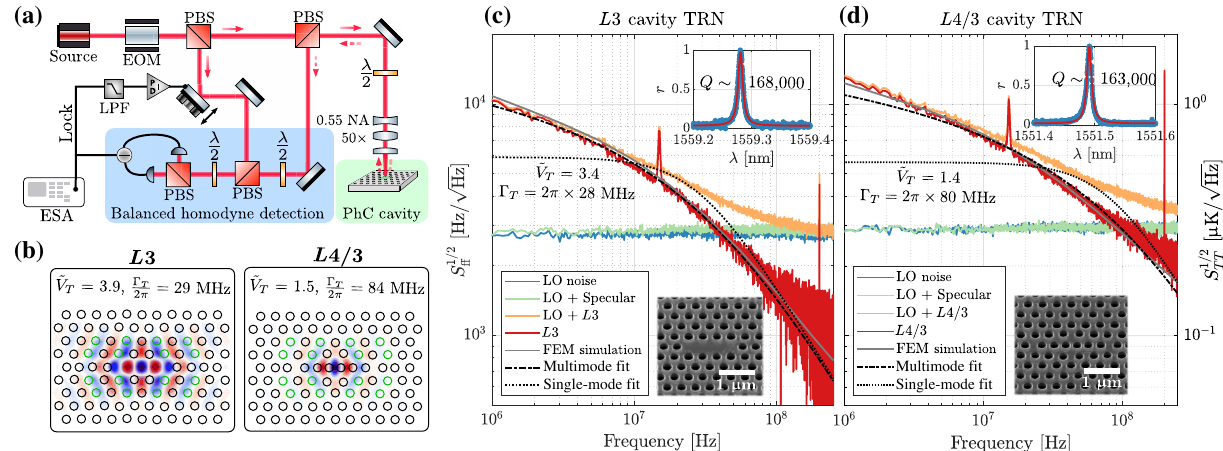
FIG. 2. Calibrated measurement of TRN in high- Q=V silicon PhC cavities. A shot-noise-limited, balanced homodyne detector (a) is locked to the phase quadrature of the cavity reflection signal and records the spectrum of resonant frequency fluctuations. The finite difference time domain (FDTD) simulated mode profiles, thermal mode volume L 3 and L 4 = 3 devices tested are shown in (b). The radii of the green holes are increased by up to 5% to form superimposed gratings which improve vertical coupling efficiency. The measured spectral density of cavity resonant frequency and temperature noise — S f Þ , respectively — (red) for L 3 (c) and L 4 = 3 (d) cavities are compared to noise from a specular reflection off the sample surface, and S TT ð finite-element method (FEM) simulations of cavity TRN, as well as single- and multimode fits. The listed multimode fit parameters agree with the predicted values in (b). Inset reflection spectra of each device reveal quality factors on the order of 10 5 , which compare favorably with the FDTD computed values ( 1 . 7 × 10 5 and 1 . 6 × 10 5 for the L 4 = 3 and L 3 , respectively). Micrographs of the fabricated designs with enlarged holes relative to the optimal designs in (b) are also